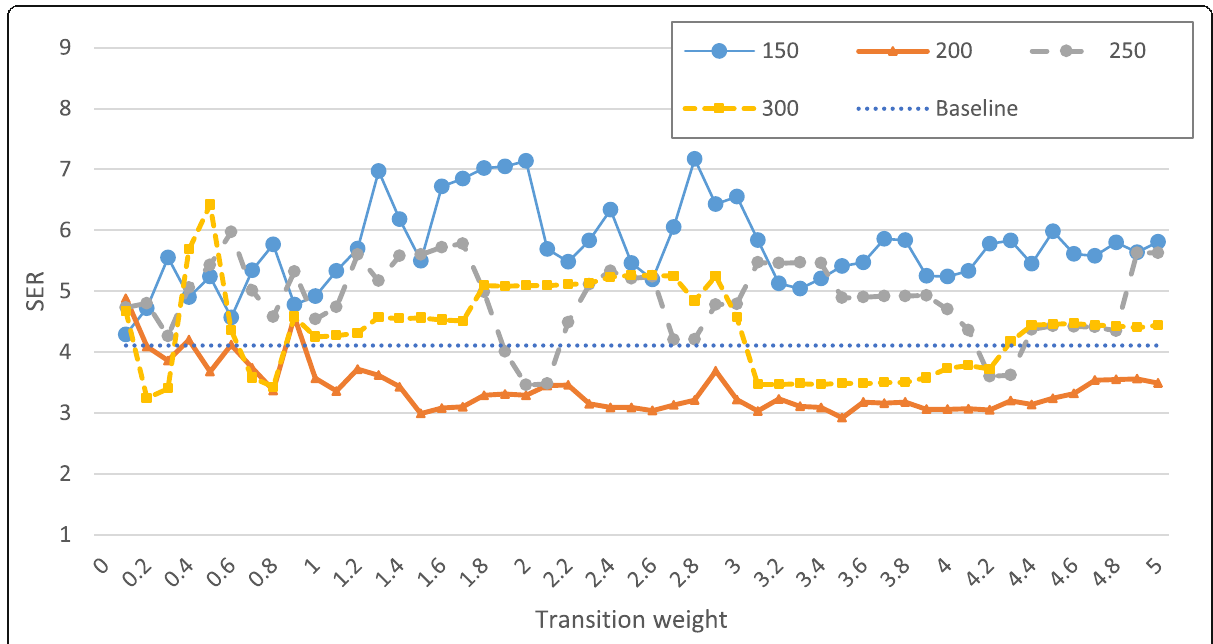
Fig. 5 SER of the development set for minimum duration of speaker turn of 150, 200, 250, and 300 frames against the transition weight